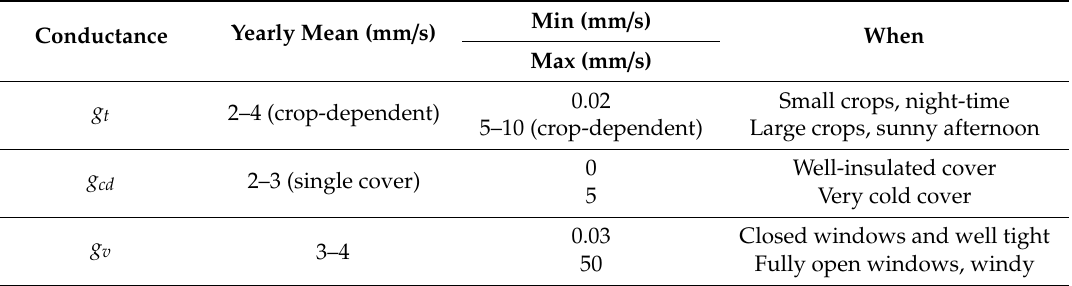
Table 2. Typical values of the three conductances on the vapor pathway (see definitions above). The values presented are based on the authors’